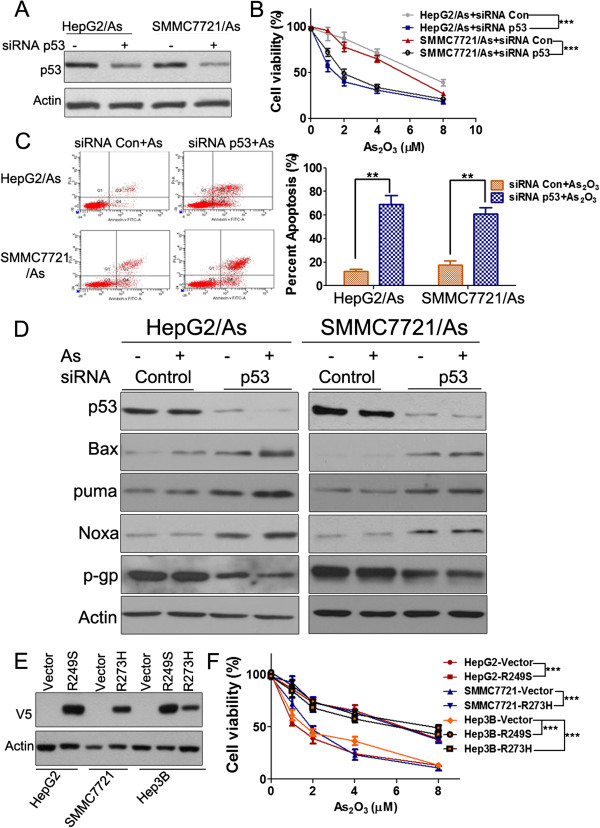
Mutp53 plays an important role in HCC arsenic trioxide resistance. (A) Knockdown of mutp53 in HCC resistant cells. (B) MTT assays were performed after cells were treated with arsenic trioxide for 48 h. ***: P < 0.001 versus negative siRNA-transfected cells. (C) Cells were treated with arsenic trioxide (2 μM) for 48 h before performing apoptosis assay. **, P < 0.01 versus negative siRNA-transfected cells. Histograms represent averages of three independent experiments. (D) Cells were treated with arsenic trioxide (2 μM) for 24 h after siRNA transfection (48 h). The target proteins were detected by Western blot analyses. (E) One representative Western blot from three independent experiments demonstrates the accumulation of the V5-tagged exogenous mutant p53 in each cell lines. (F) MTT assays were performed after cells were treated with arsenic trioxide for 48 h. ***: P < 0.001 versus vector control cell lines.